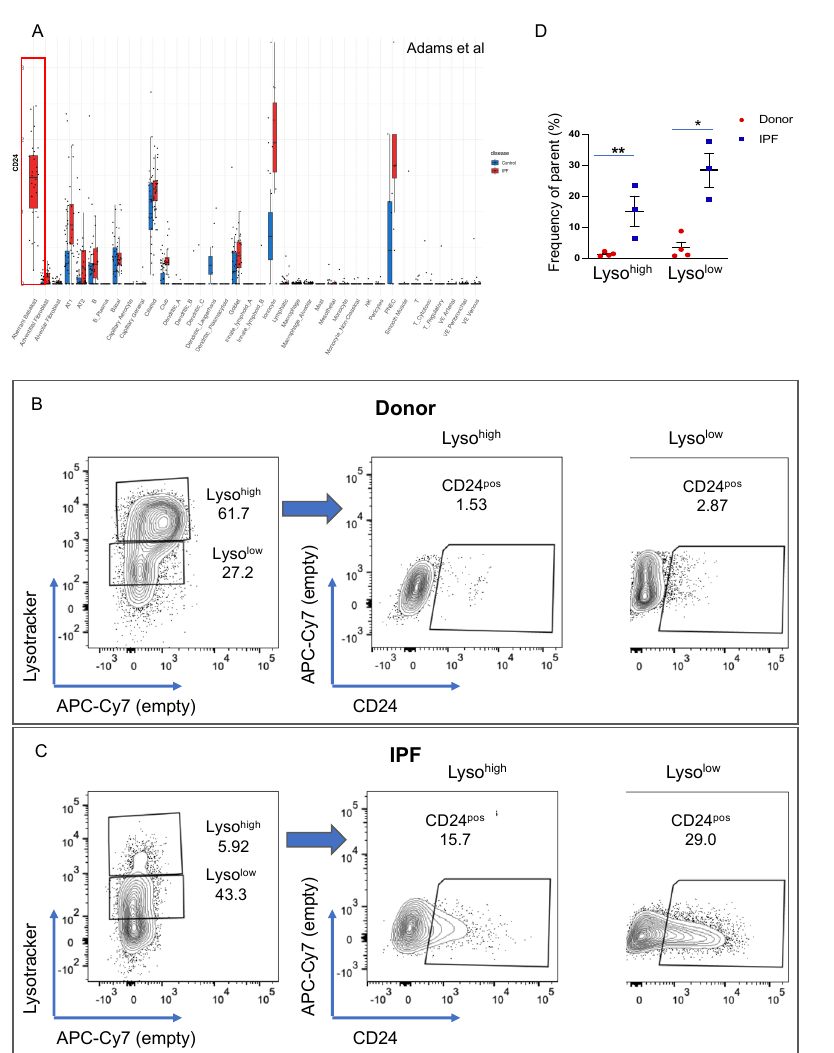
Figure 7. CD24 expression in donor and IPF lung. ( A ) Differential expression of CD24 in donor and IPF scNGS data published by Adams et al. ( B ), ( C ) Flow cytometry analysis of donor (n = 4) ( B ) and IPF (n = 3) ( C ) samples of LysoTracker incorporation in the epithelial cell compartment (left panel). Right panels show the expression of CD24 in the Lyso high and Lyso low populations shown in the panels on the left. ( D ) Quantification of the data in ( B , C ) showing the difference between donor and IPF Lyso high and Lyso low populations. Average donor Lyso high CD24 pos 1.4%, donor Lyso low CD24 pos 0.34%; IPF Lyso high CD24 pos 15.2% and IPF Lyso low CD24 pos 28.53%. Data are presented as the means ± SEM of the percentage of cells from the parent population. Statistical analysis was performed on log(10) values. * p < 0.05, ** p < 0.01, n.s. = not significant by